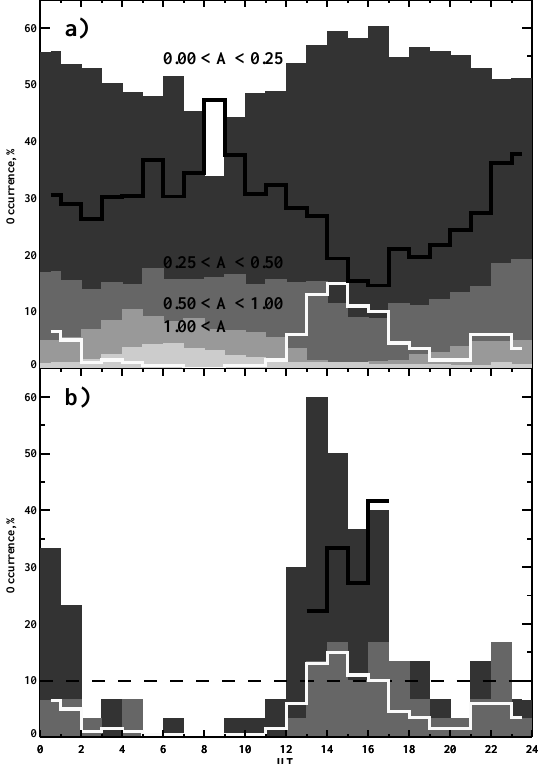
Fig. 5. The occurrence of various absorption levels for (a) all 731 days and (b) 111 days with at least one 1-h HCP during 2000–2001. The white line shows the HCP occurrence (the same as in Figs. 3 and 4) and the black line shows the occurrence of the 0.25 <A< 0.50 level relative to the one of 0.0 <A< 0.25.